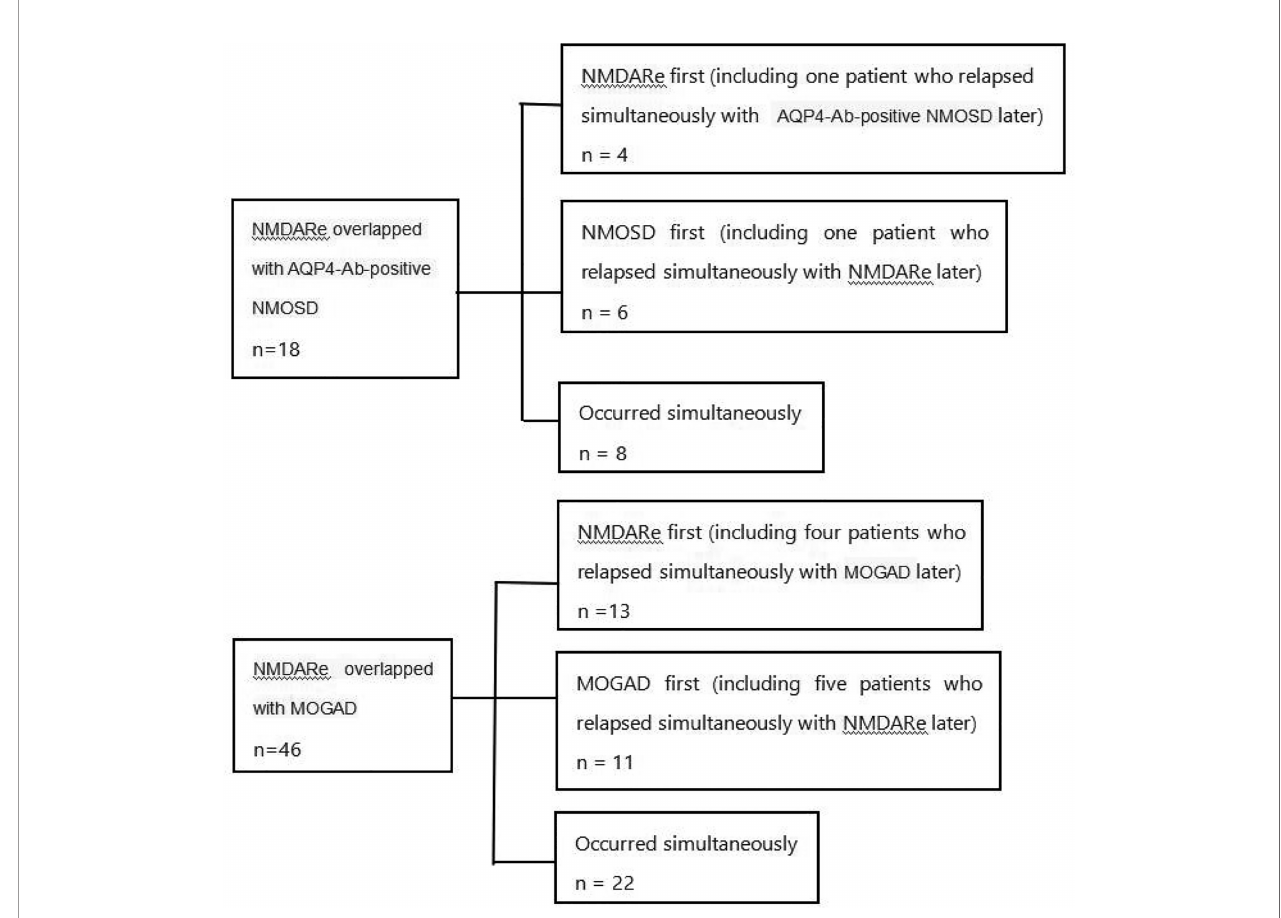
FIGURE 2 | Details of the sequence of onset in patients with overlapping AQP4-Ab-positive NMOSD or MOGAD. NMDARe, anti-N-methyl-d-aspartate receptor encephalitis; AQP4-Ab-positive NMOSD, aquaporin-4-antibody-positive neuromyelitis optica spectrum disorder; MOGAD, myelin oligodendrocyte glycoprotein antibody-associated disease; NMOSD, neuromyelitis optica spectrum